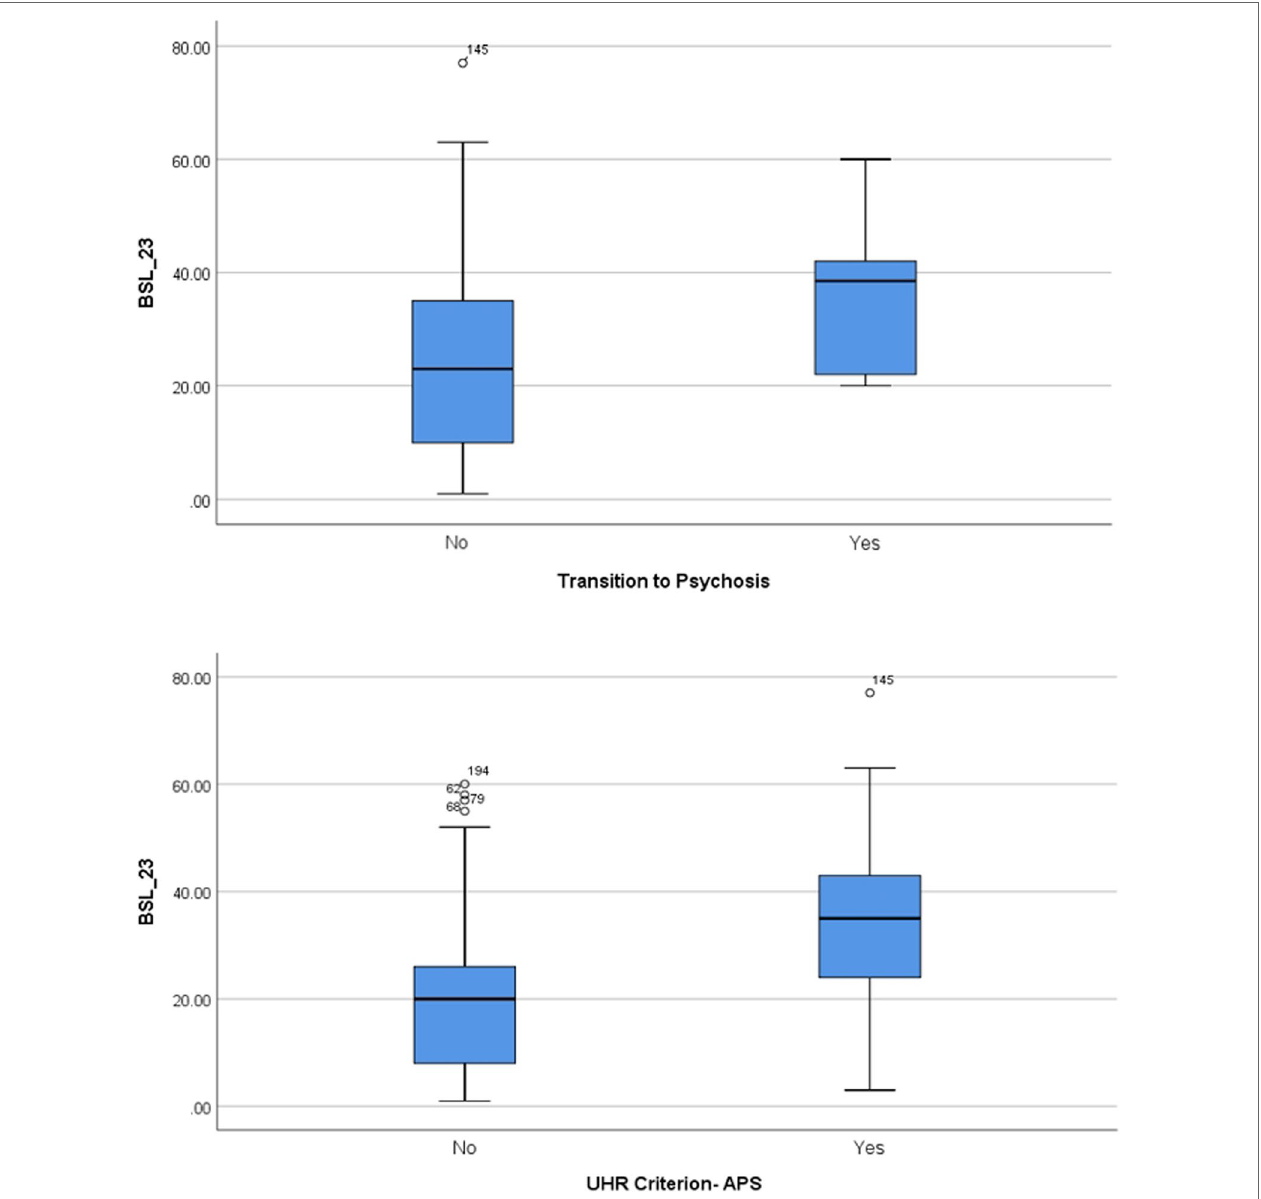
FIgURe 2 | Borderline symptom list (BSL) score separated according transition into manifest psychosis and according to the presence of the attenuated positive symptom (APS) criterion.